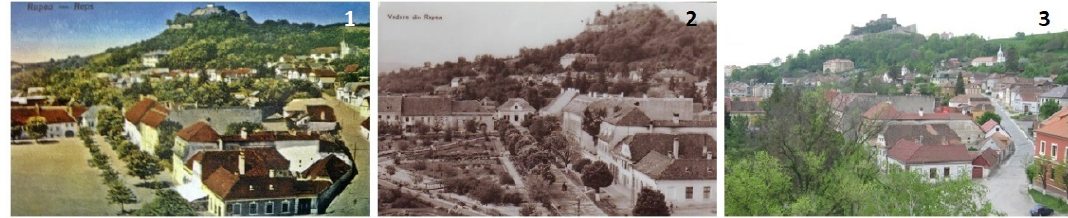
Figure 9: Rupea town’s central square functional reconversion, 1 – postcard from